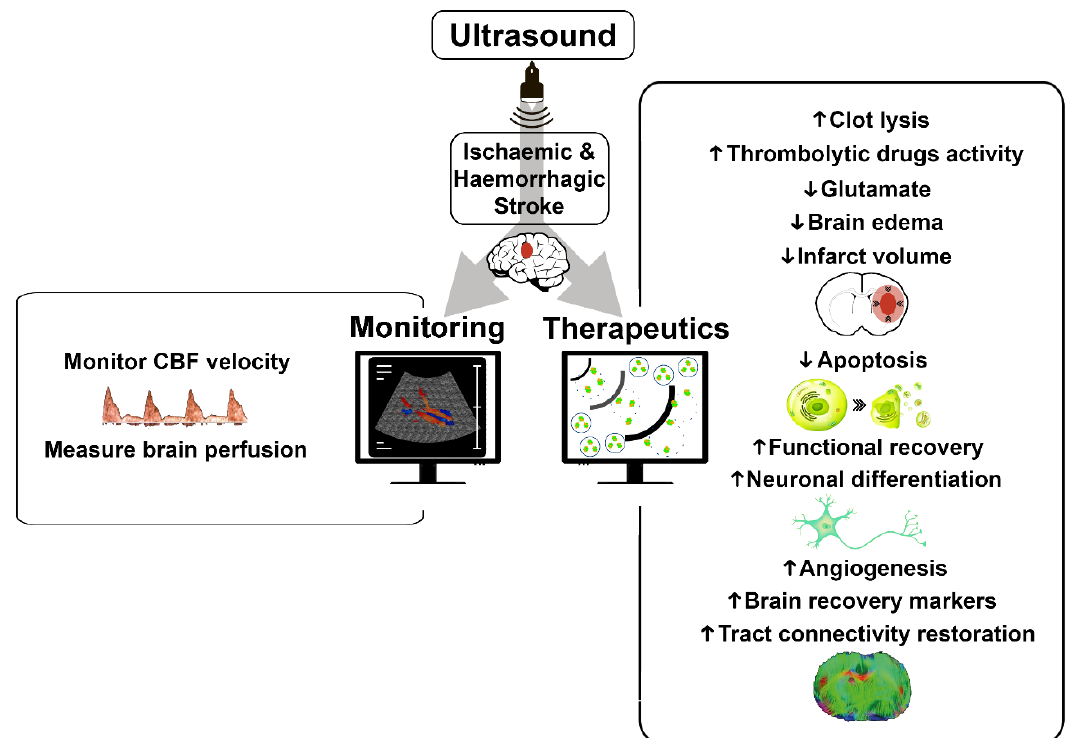
Figure 1. Potential of ultrasound in animal models of stroke. Ultrasound applied to brain after stroke can provide rapid and additional information for monitoring or as a specific and local treatment. Main effects of ultrasound in monitoring and as a therapeutic tool are summarized in the figure. CBF: cerebral blood flow. Up arrows mean increase and down arrows mean decrease.